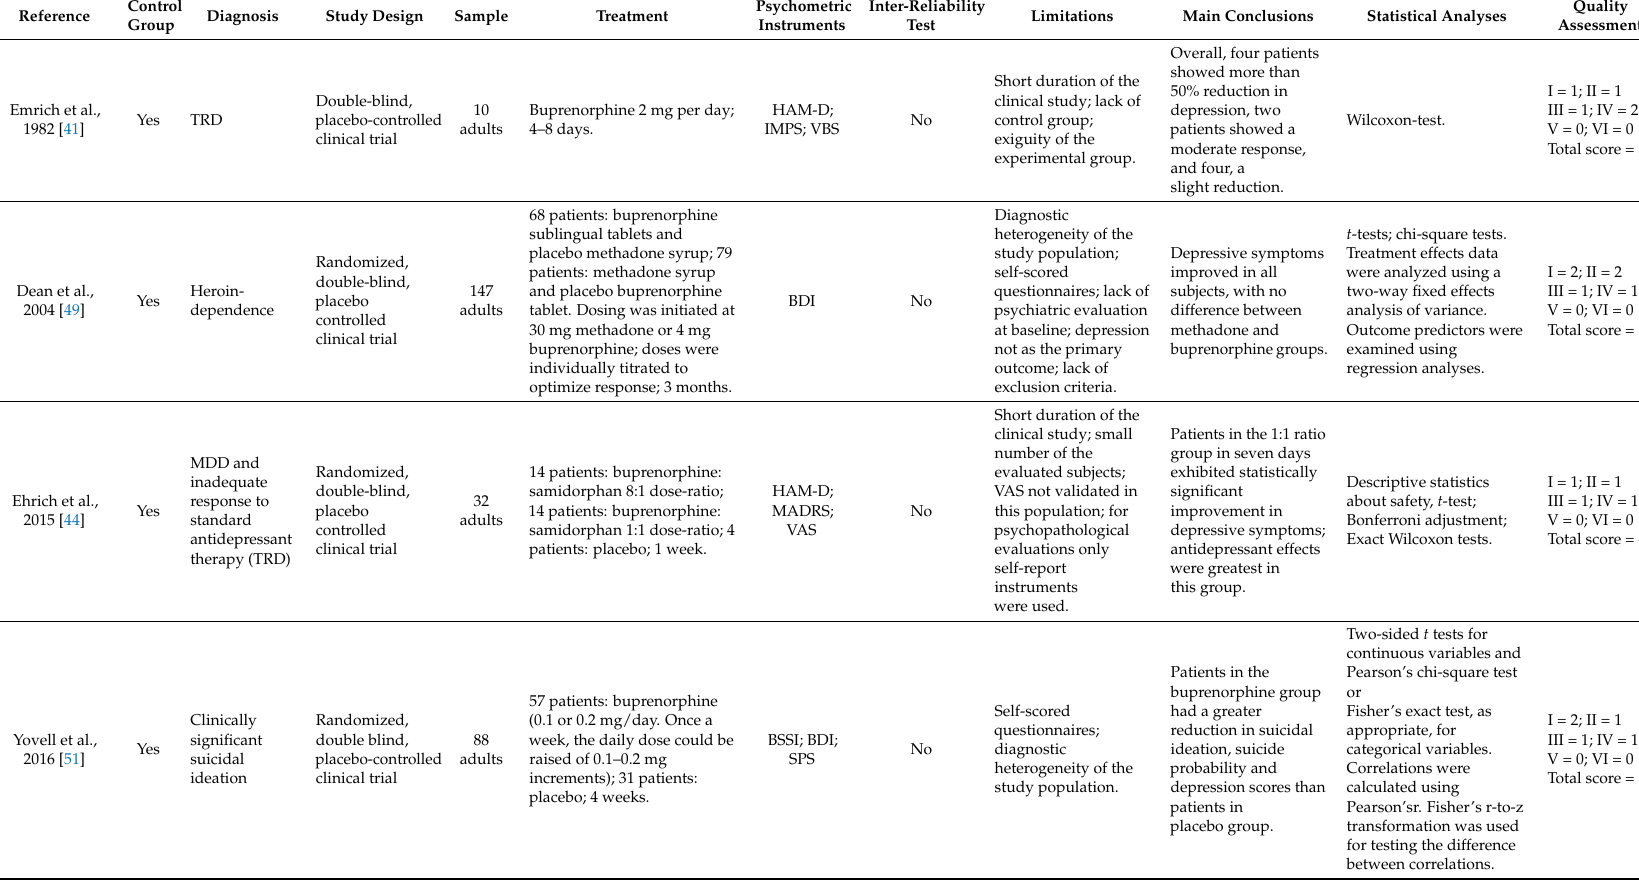
Table 4. Summary of the most relevant randomized, double-blind, placebo-controlled clinical trials concerning BUP and depression/suicidal behavior included in the present